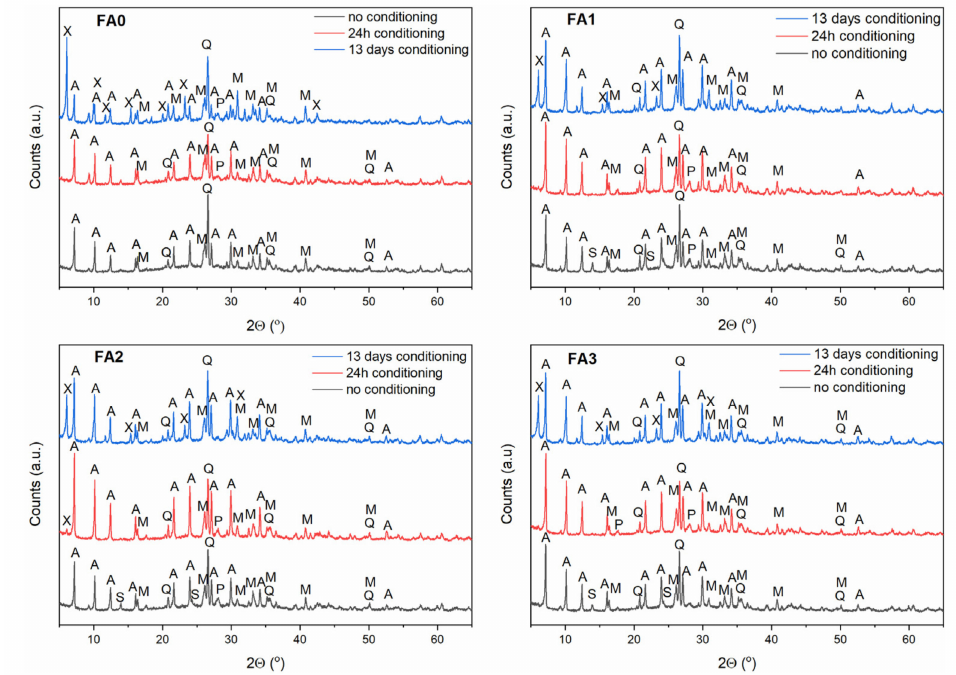
Figure 7. The effect of FA milling and solution conditioning on FA the conversion into Na-A zeolite phase. Clarifications: A—zeolite Na-A, M—mullite, Q—quartz, S—sodalite, P—zeolite